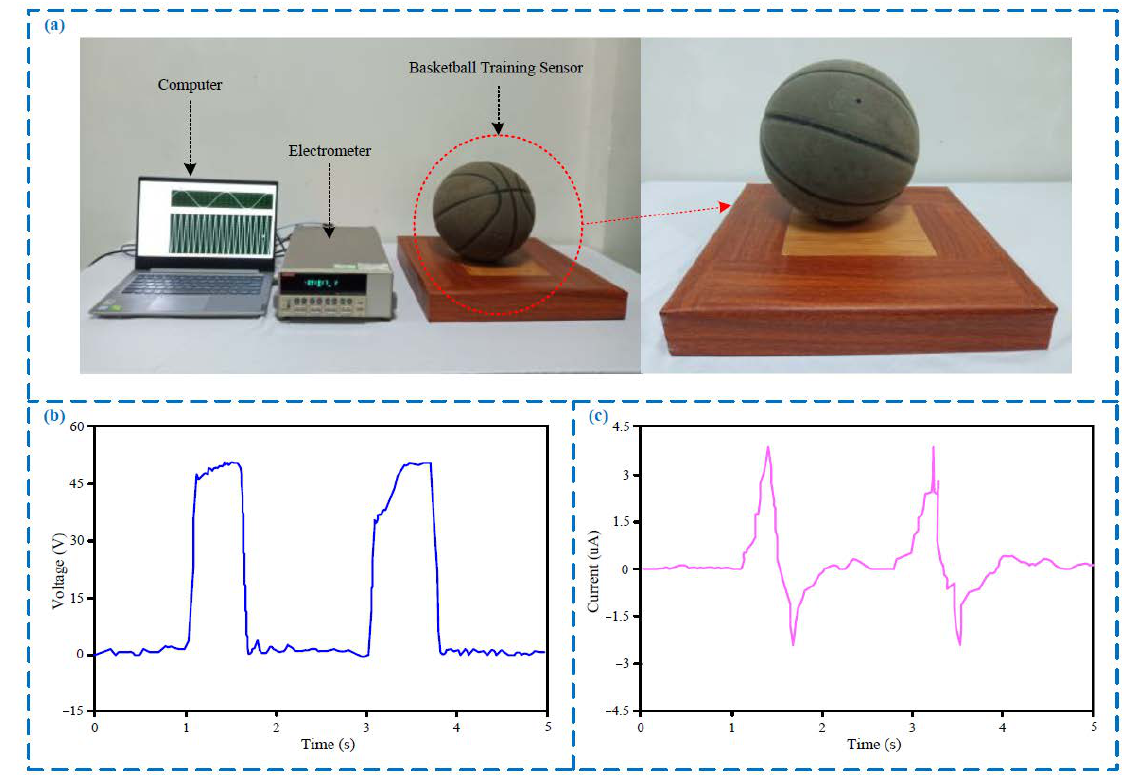
Figure 2. The output signal of the sensor. ( a ) Pictures about the test devices and the sensor; ( b ) output voltage signal of the sensor; ( c ) output current signal of the sensor.